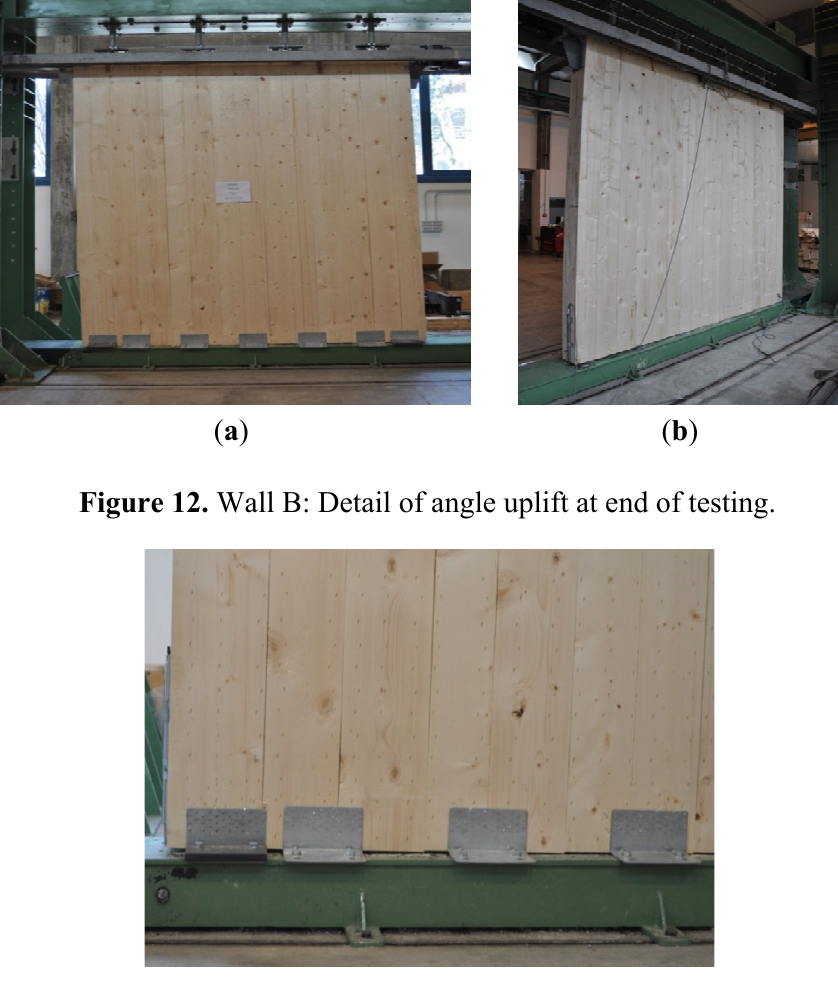
Figure 13. Wall C: Shear deformation between vertical boards at end of testing: ( a ) Front face; ( b ) Rear